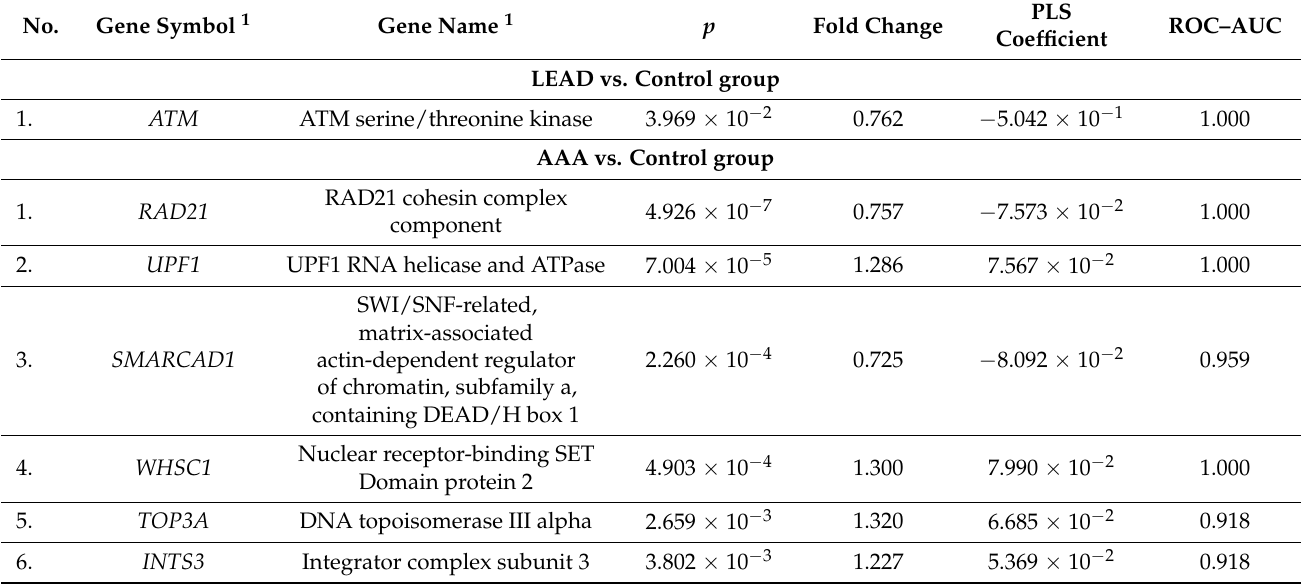
Table 2. Differential expression parameters of genes selected from the pairwise and pooled group comparisons. The table presents p (FDR with Benjamini–Hochberg correction) and fold change values received from DESeq2 analysis, PLS coefficients received from UVE-PLS analysis, and areas under ROC curves (ROC–AUC) received from ROC analysis. Genes were ordered within each comparison according to increasing p